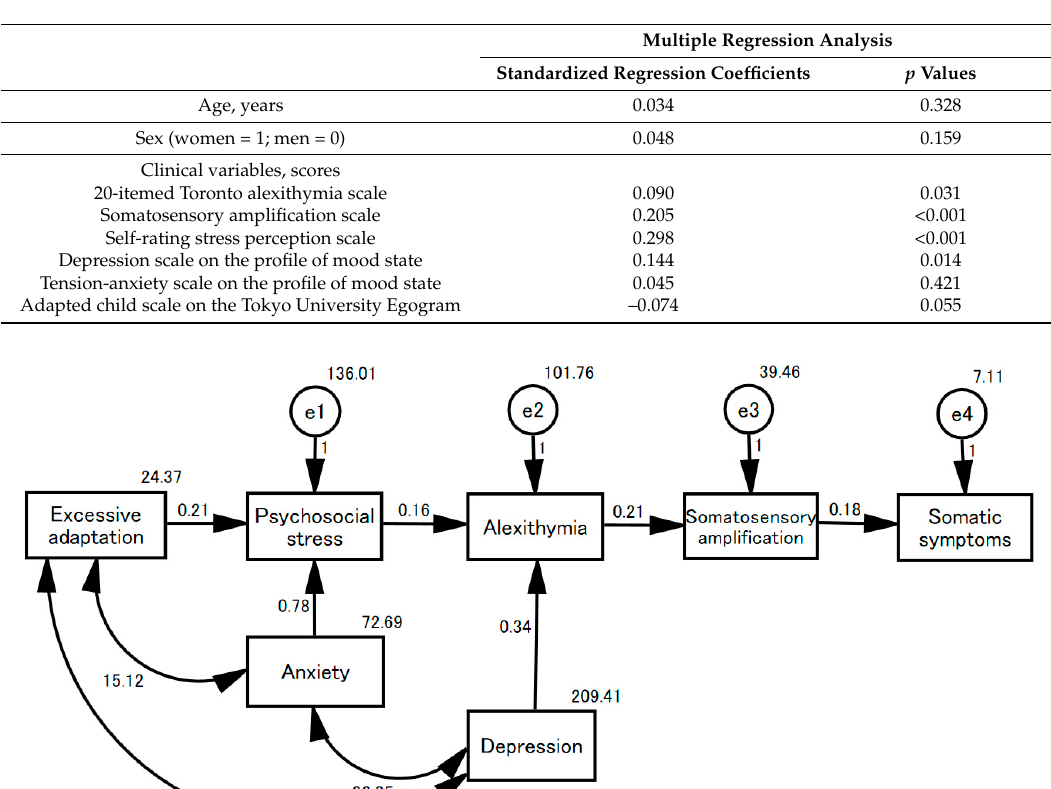
Table 3. Prediction of the total number of somatic symptoms: results of univariate and multivariate analyses ( n = 604).